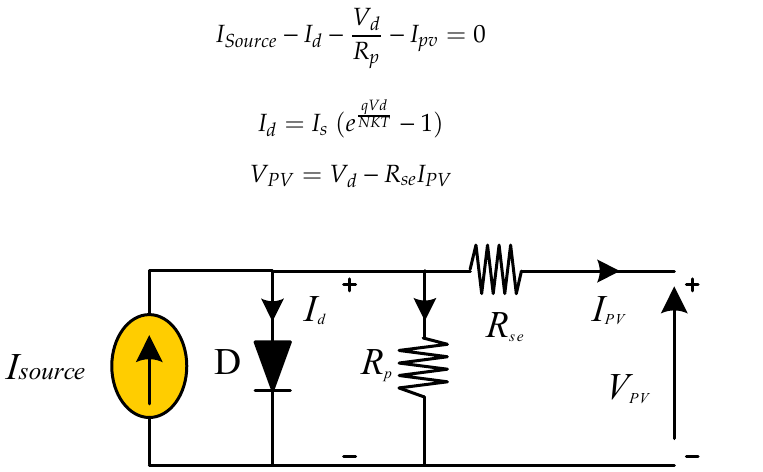
Figure 1. Equivalent circuit of practical single diode model solar cell.